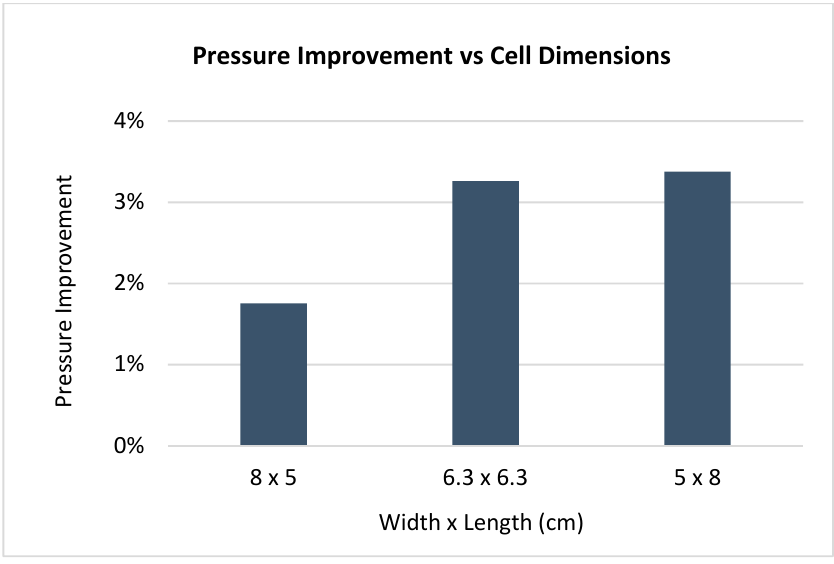
Figure 5. Pressure improvement for 40 cm 2 cells with varying dimensions.